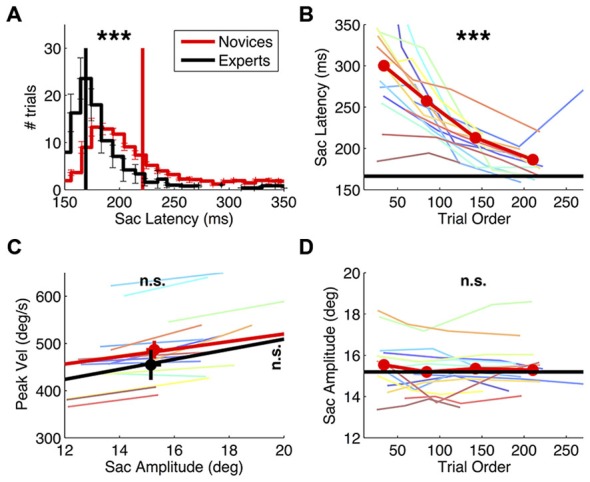
Effect of practice on saccade behavior. Saccade latency and main sequence in novice vs. expert observers and evolution of novices’ saccade behavior over the course of the experiment. (A) Saccade latency histogram, computed for the individual subjects and then averaged, with errorbars showing s.e. in each bin. Vertical lines mark the grand averages of saccade latency. Asterisks at the top of the panel report the result of a two-sample t-tests comparing the averages in the two groups (***p < 0.001). (C) Saccade main sequence, plotting peak velocity against amplitude. Colored lines give the best fit line for the individual novice subjects; thick red and black lines give the average fit for the two subjects groups, and symbols with errorbars show grand averages and their s.e.. The results of two-sample t-tests comparing the average peak velocity and amplitude in the two groups are marked on the right and at the top of the graph respectively (n.s. = not significant). (B–D) Saccade latency and amplitude for novice subjects, computed after ranking trials according to their presentation order and averaging values in the four quartiles; colored lines show the individual novice subjects, the thick red line gives the averages in the novices group; asterisks report the results of paired t-tests comparing the first vs. the last quartile. For reference, the average in the experts’ group in also shown (black line).